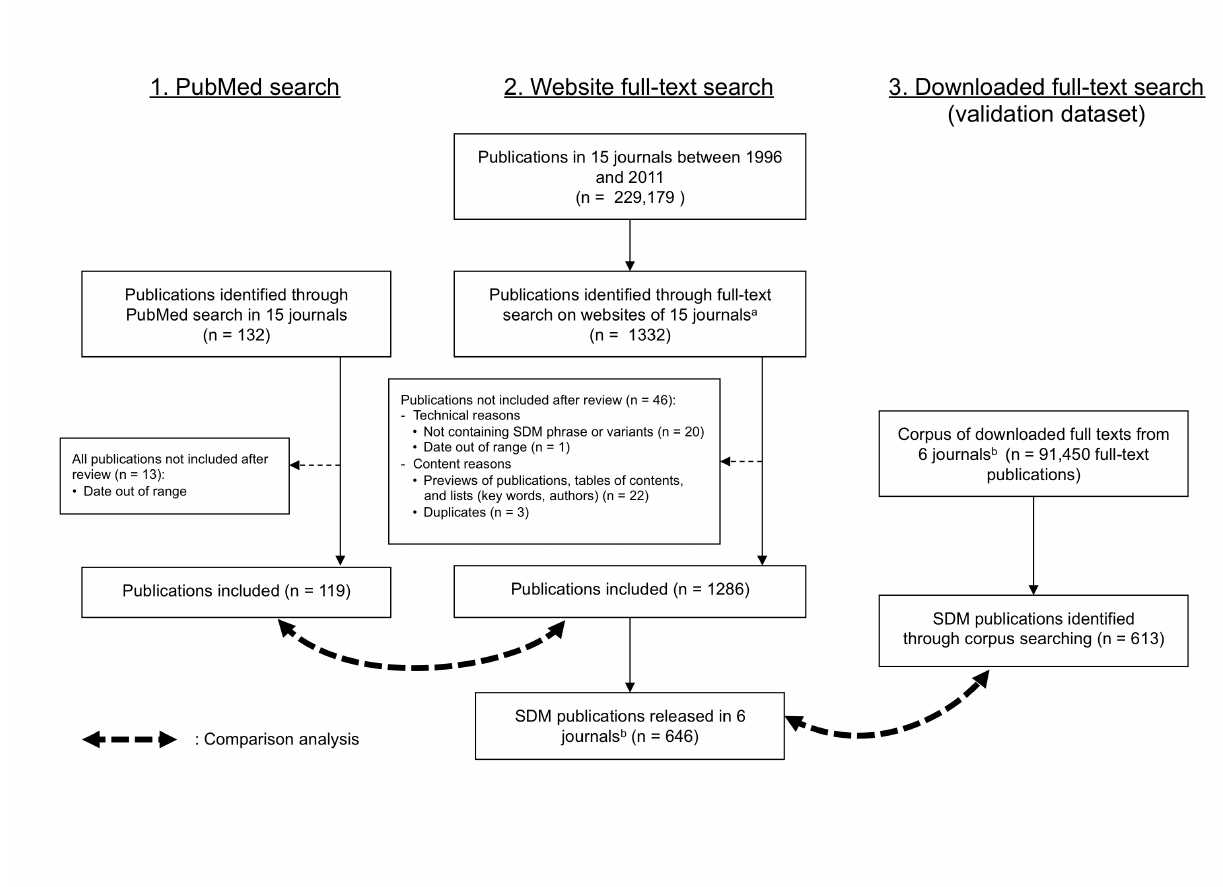
Figure 1. Flow chart of the search methods. a Canadian Medical Association Journal : publications not available in full text for years 1996-1999, identified through PubMed Central. b The 6 journals which collaborated for collecting full-text publications: British Medical Journal; Canadian Medical Association Journal ; Mayo Clinic Proceedings ; American Journal of Preventive Medicine ; Journal of General Internal Medicine ; Journal of Pain and Symptom